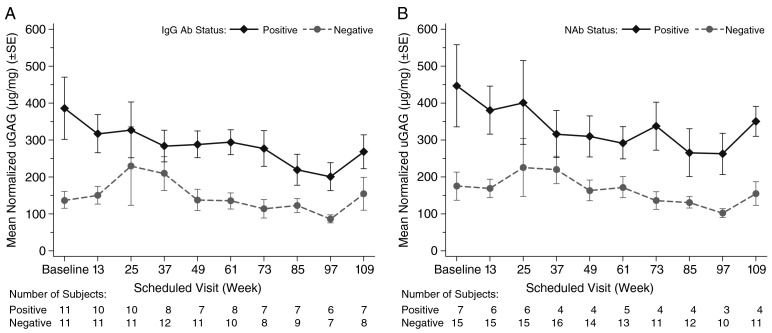
Mean normalized uGAG (μg/mg) by visit and IgG Ab status (A) and NAb status (B).Ab, antibody; IgG, immunoglobulin G; NAb, neutralizing antibodies; uGAG, urinary glycosaminoglycan.